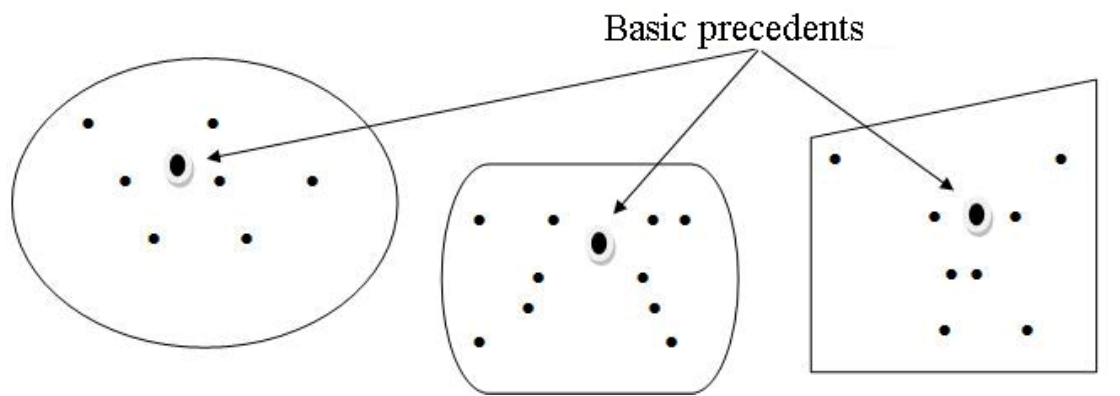
Figure 5. K-method clustering and the selection of pairs of basic precedents (precedent-response) of a training sample on neural network layers.